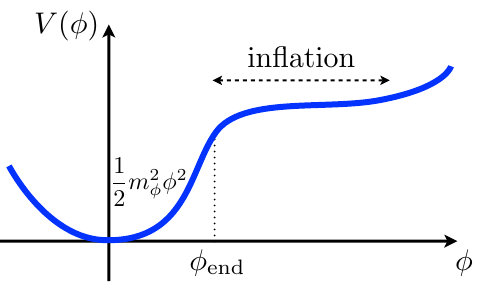
Figure 1 . Schematic of inflaton potential for small-field